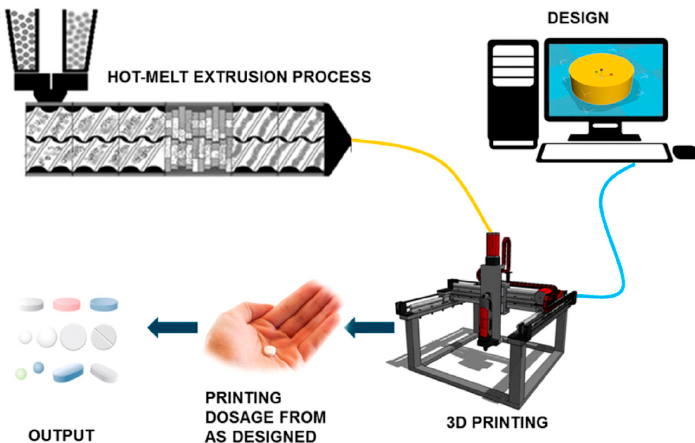
Figure 9. Schematic of a combined Hot-Melt Extrusion (HME) and FDM 3D printing into a single continuous process (Reproduced with permission from reference [16], Elsevier,